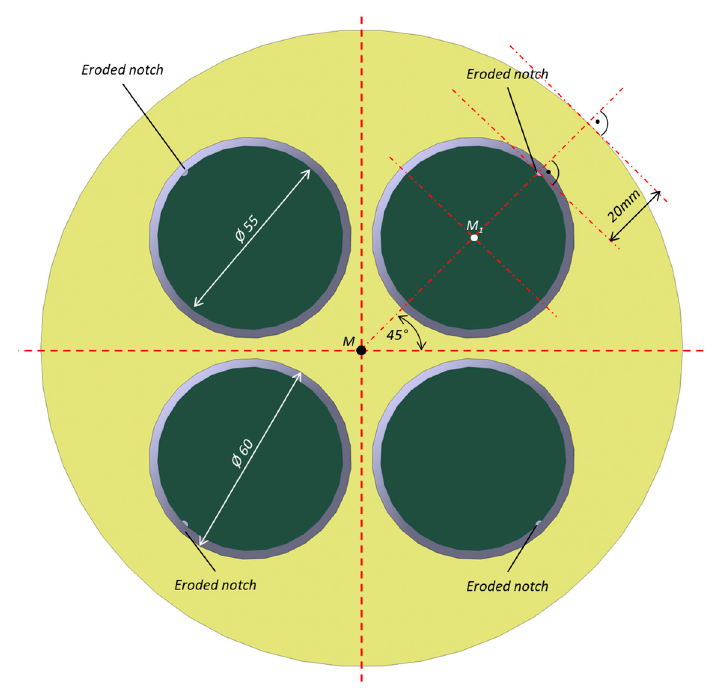
Figure A1. Extraction of 1:3 scaled specimens out of a railway axle blank.